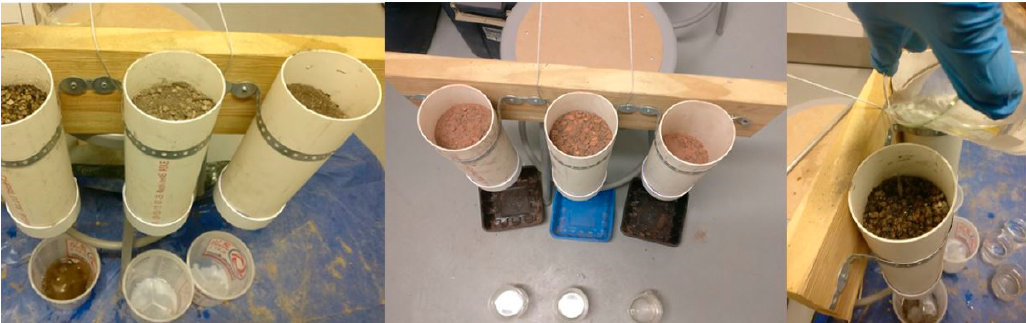
Figure 4. A testing device for demonstrating the water retention capacity of samples. The 3 tubes in the left image consist of Type 1 substrate, the tubes in the middle image consist of Type 2 substrate and the image on the right demonstrates the addition of distilled water into the substrates using a glass beaker.